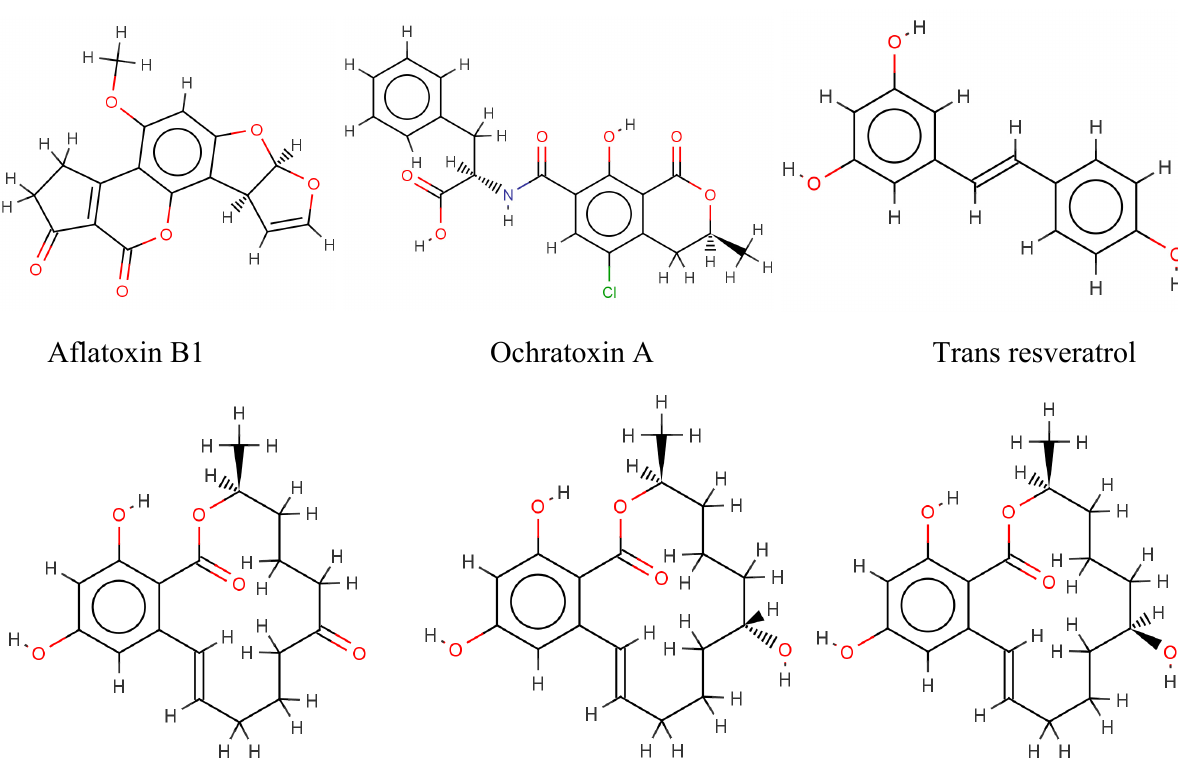
Figure 1. Structure of the six ligands considered in the present